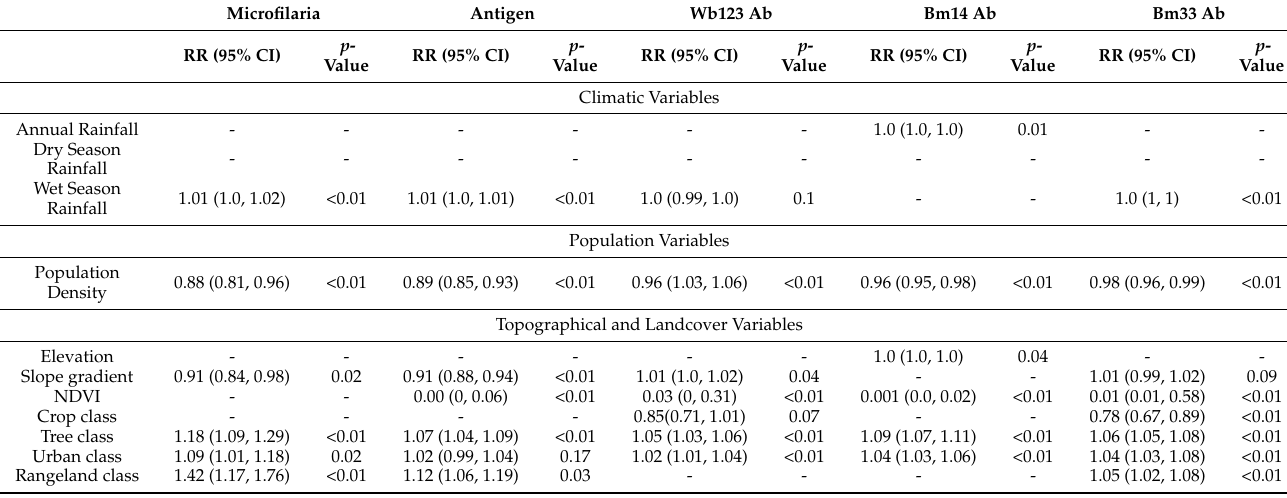
Table 4. Results of the multivariable Poisson regression models for the association between the five lymphatic filariasis infection markers sampled in the 2016 ‘TAS Strengthening Survey’ in American Samoa and environmental variables: rainfall (mm), population density (persons/km 2 ), elevation (m), slope gradient (degrees), NDVI, landcover class (percent of village buffer zone covered), and LF infection